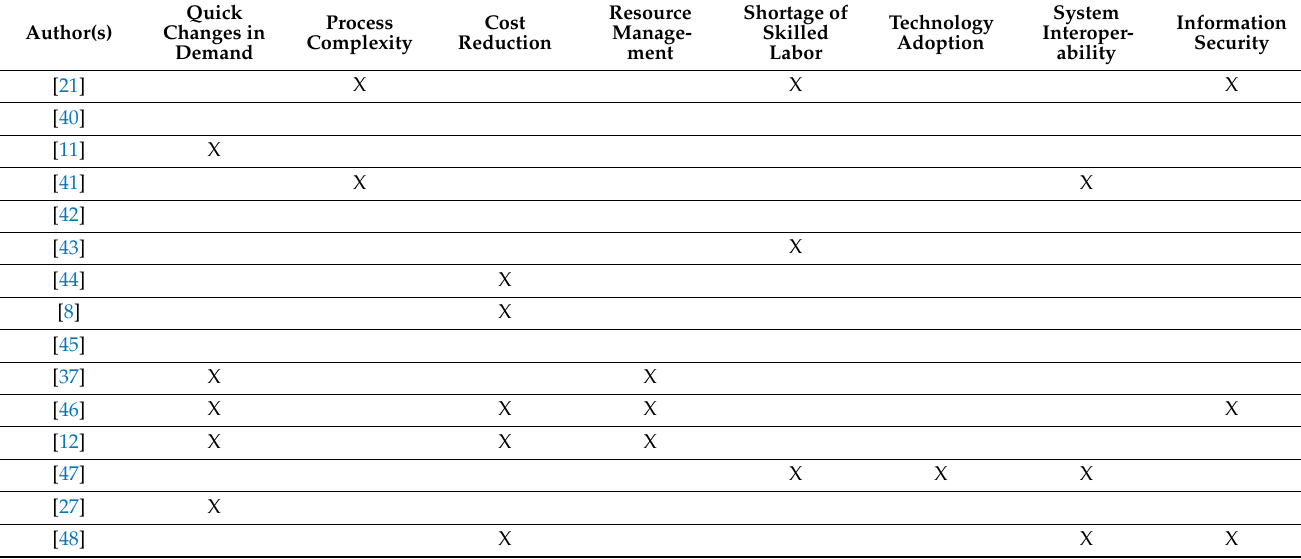
Table 7 discusses the sub-categories under the challenges category, in which the pre- dominant sub-categories were cost reduction (12), rapid changes in demand (9), information security (8), resource management, and lack of skilled professionals (7). Table 7. Sub-categories for